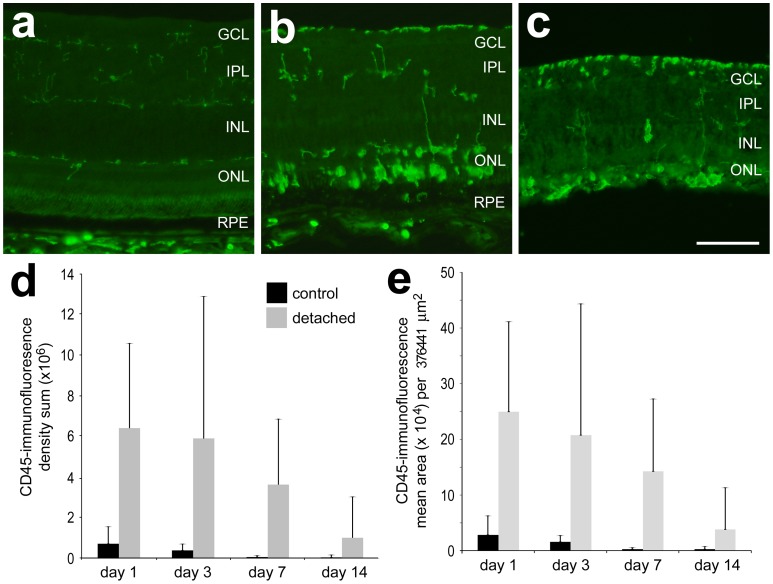
Microglia are up-regulated in chick SA and HA RD.SA RDs (b) and HA RDs (c) show up-regulation of microglial marker CD45 (green) in areas of RD compared to control retina (a). The SA RD is resolved by day 3. The microglia acquire amoeboid morphology and migrate to the outer retina/subretinal space. Quantitation of CD45 staining in HA RD over time (d, density sum and e, mean area).